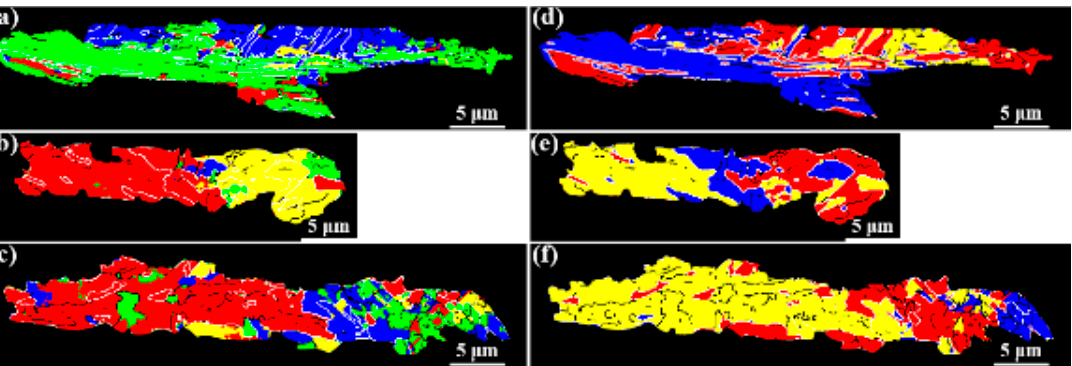
Figure 11. CP maps of specimen A ( a ), specimen B ( b ), specimen C ( c ), and the Bain maps ( d – f ) corresponding to ( a – c ), respectively. Black and white lines are low ‐ angle (5° < θ < 15°) and high ‐ angle ( θ > 15°) boundaries.